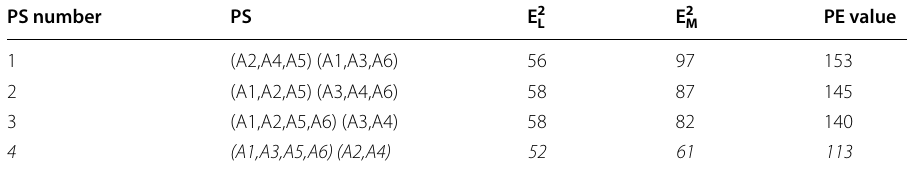
Table 12 Fragmentation